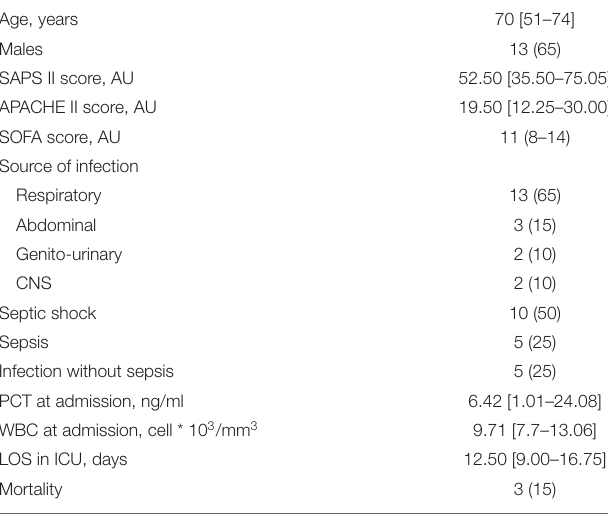
TABLE 1 | Descriptive of the study